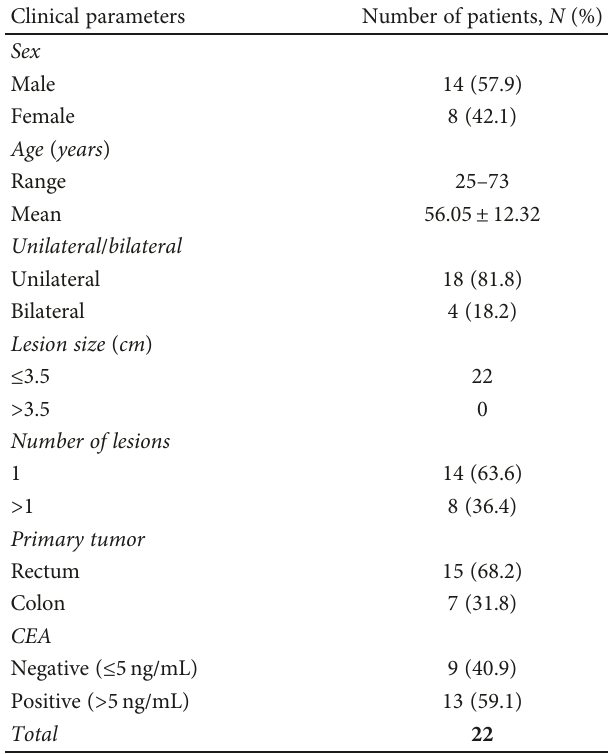
Table 1: Clinical features of the patients. Clinical